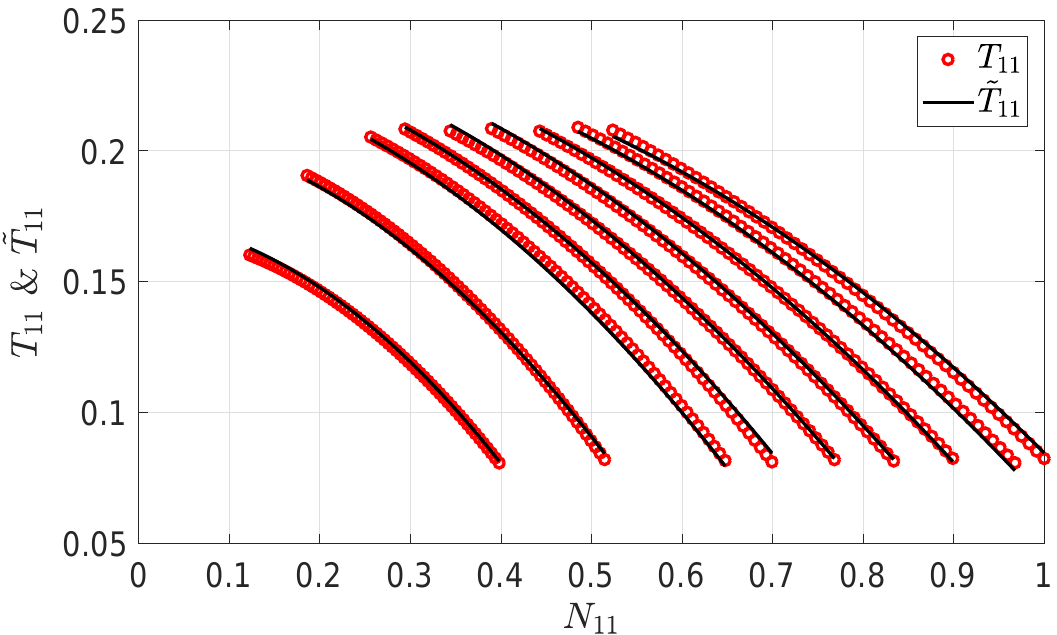
Figure 4. ˜ T 11 vs. N 11 for different values of γ .